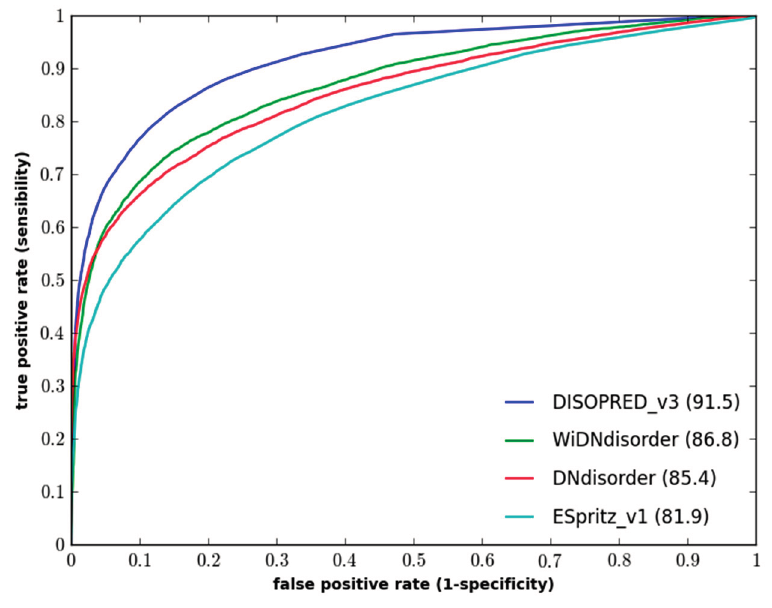
Figure 1. Performance of disorder prediction methods on the DO1111_TEST dataset.